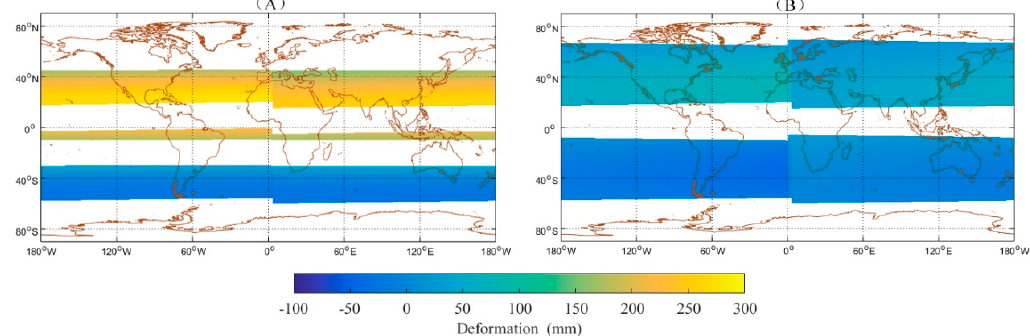
Figure 11. ( A ) and ( B ) represent the deformation distribution of the 8th and 16th revisits from 0:00 on 2 March 2018, respectively. The upper and lower parts of ( B ) can be understood as the observable deformation region of the lunar SAR from the right-looking and left-looking, respectively.